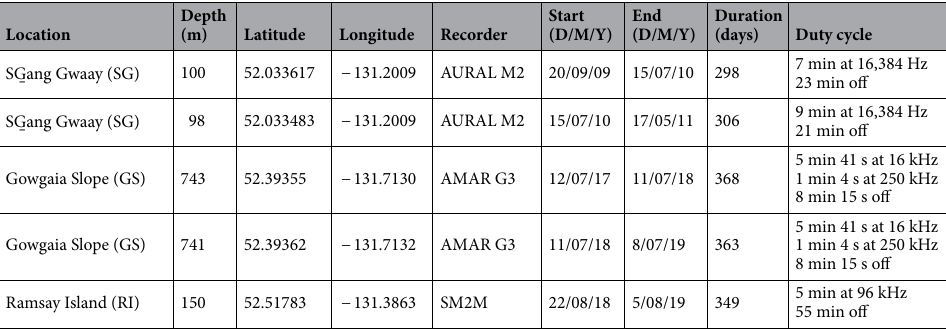
Table 1. Location, depth, acoustic recorder type, and operation time periods of the analyzed